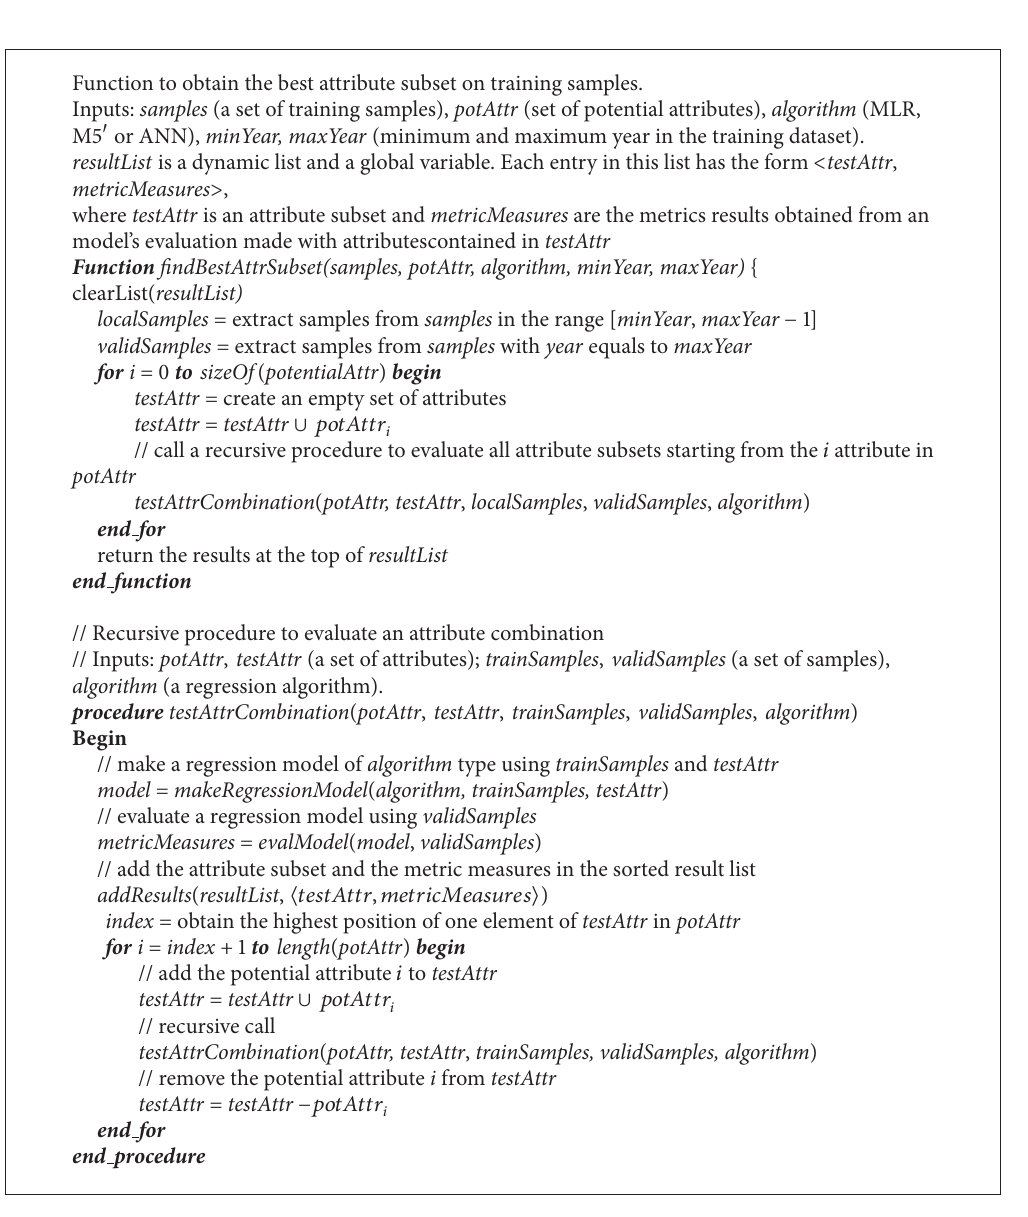
Algorithm 1: Recursive algorithm to perform the optimal attribute subset